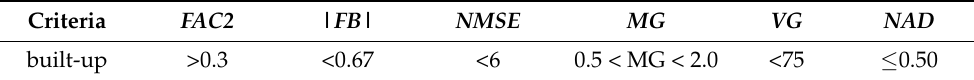
Table 1. Acceptance criteria for each performance indicator based on [24–26].